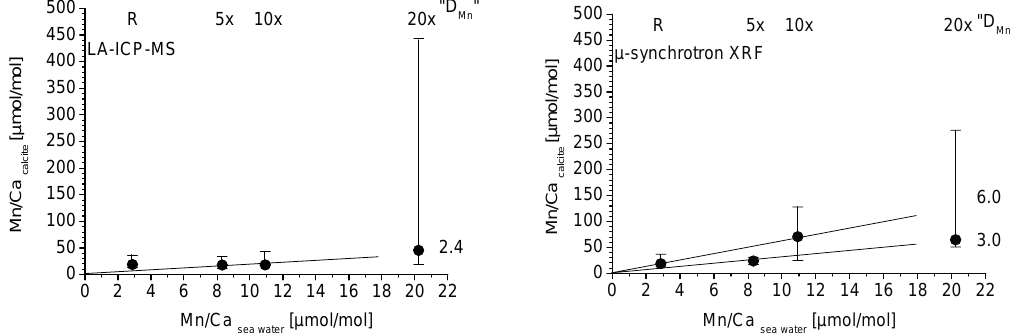
Fig. 6. Estimates for the partition coefficients for Mn. Explanation of the symbols as in Fig